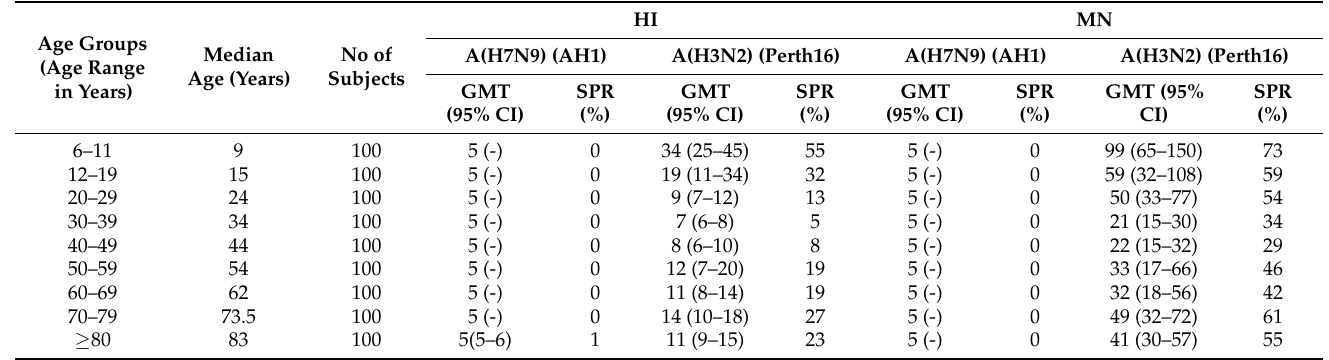
Table 2. Seroprevalence of HI and MN antibodies to A(H7N9) and A(H3N2) viruses in the US pop- ulation (2010) across 9 age groups (6–102 years, N = 900).